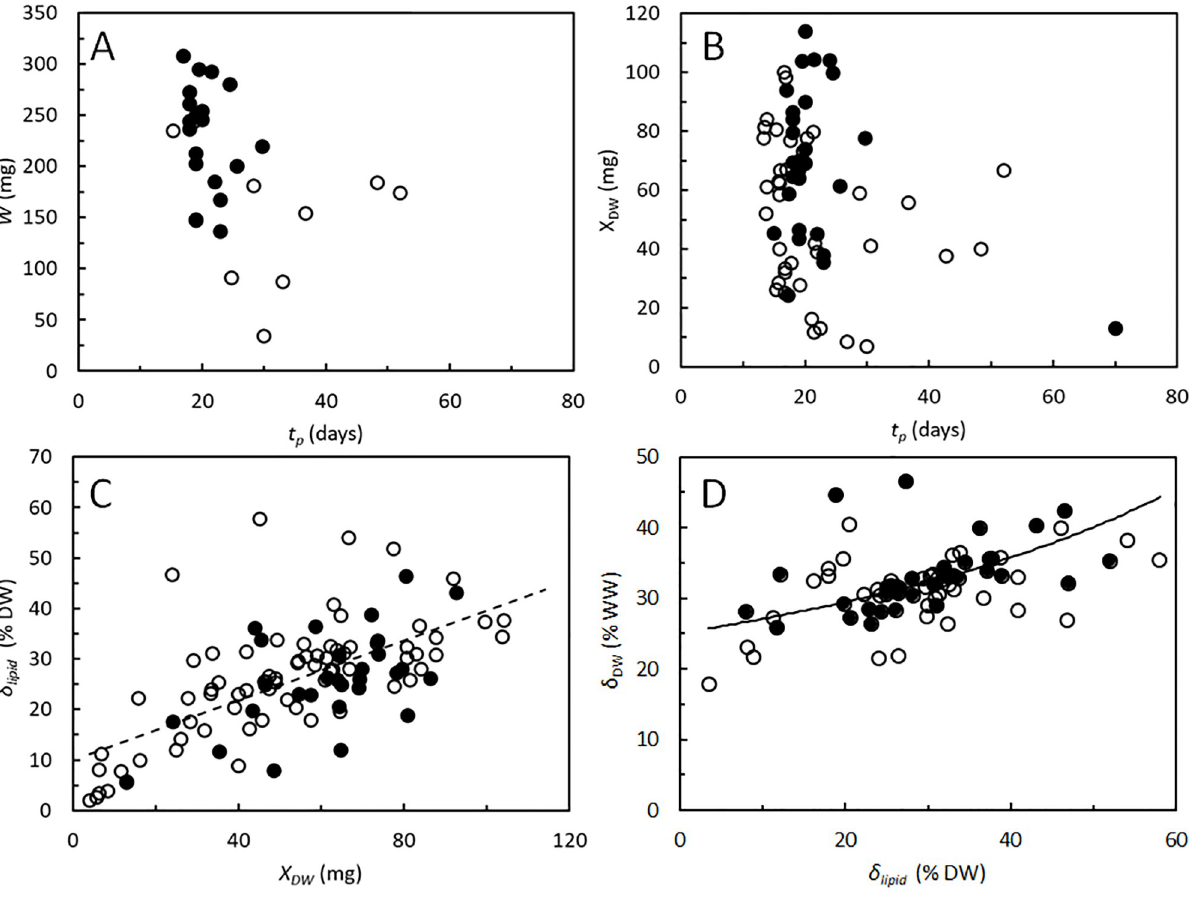
Fig 2. Hermetia illucens . A. Wet weight, W of full grown BSF larvae ( � ) or prepupae ( ● ) vs . age, t p . B. Dry weight, X DW of full grown BSF larvae ( � ) or prepupae ( ● ) vs . age. C. Lipid content, δ of full grown BSF larvae ( � ) or prepupae ( ● ) vs . dry weight. Intercept of best straight line indicates minimal lipid lipid content of 10% DW. D. Dry weight content, δ DW of full grown BSF larve ( � ) or prepupae ( ● ) vs . lipid content. Curve modelled by Eq 22. Data collected from larval cultivations in various substrate compositions, different physical conditions, and different experimental protocols [7, 9, 10, 14, 21, 22, 25–27, 35–48]. Data in S1